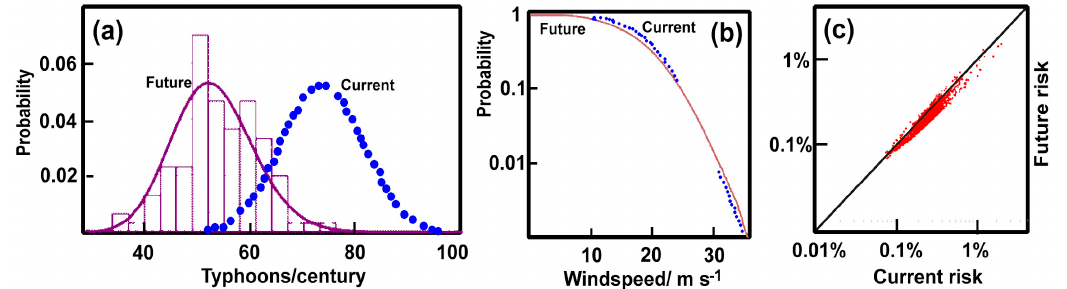
Figure 6. ( a ) Probable number of typhoons in Tokyo in 100 years from the stochastic typhoon model. Dotted and solid lines indicate present and future projections, respectively; see also [13]. ( b ) Exceedance probabilities for annual maximum wind speeds in Tokyo under current and projected climate. ( c ) Percentage wing risk for residential buildings in Japan under current and future scenarios [53].